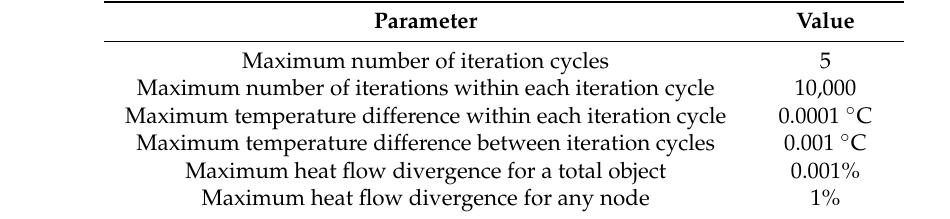
Table 5. Simulation parameters.